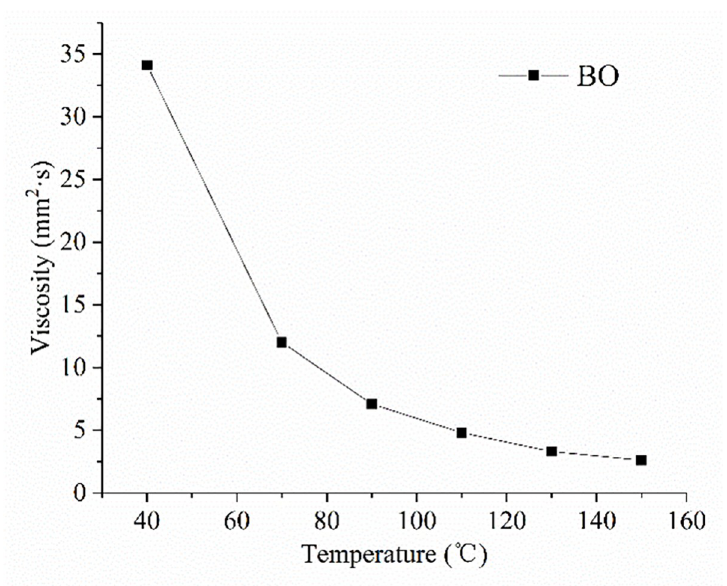
Fig 5. The base oil viscosity in different test